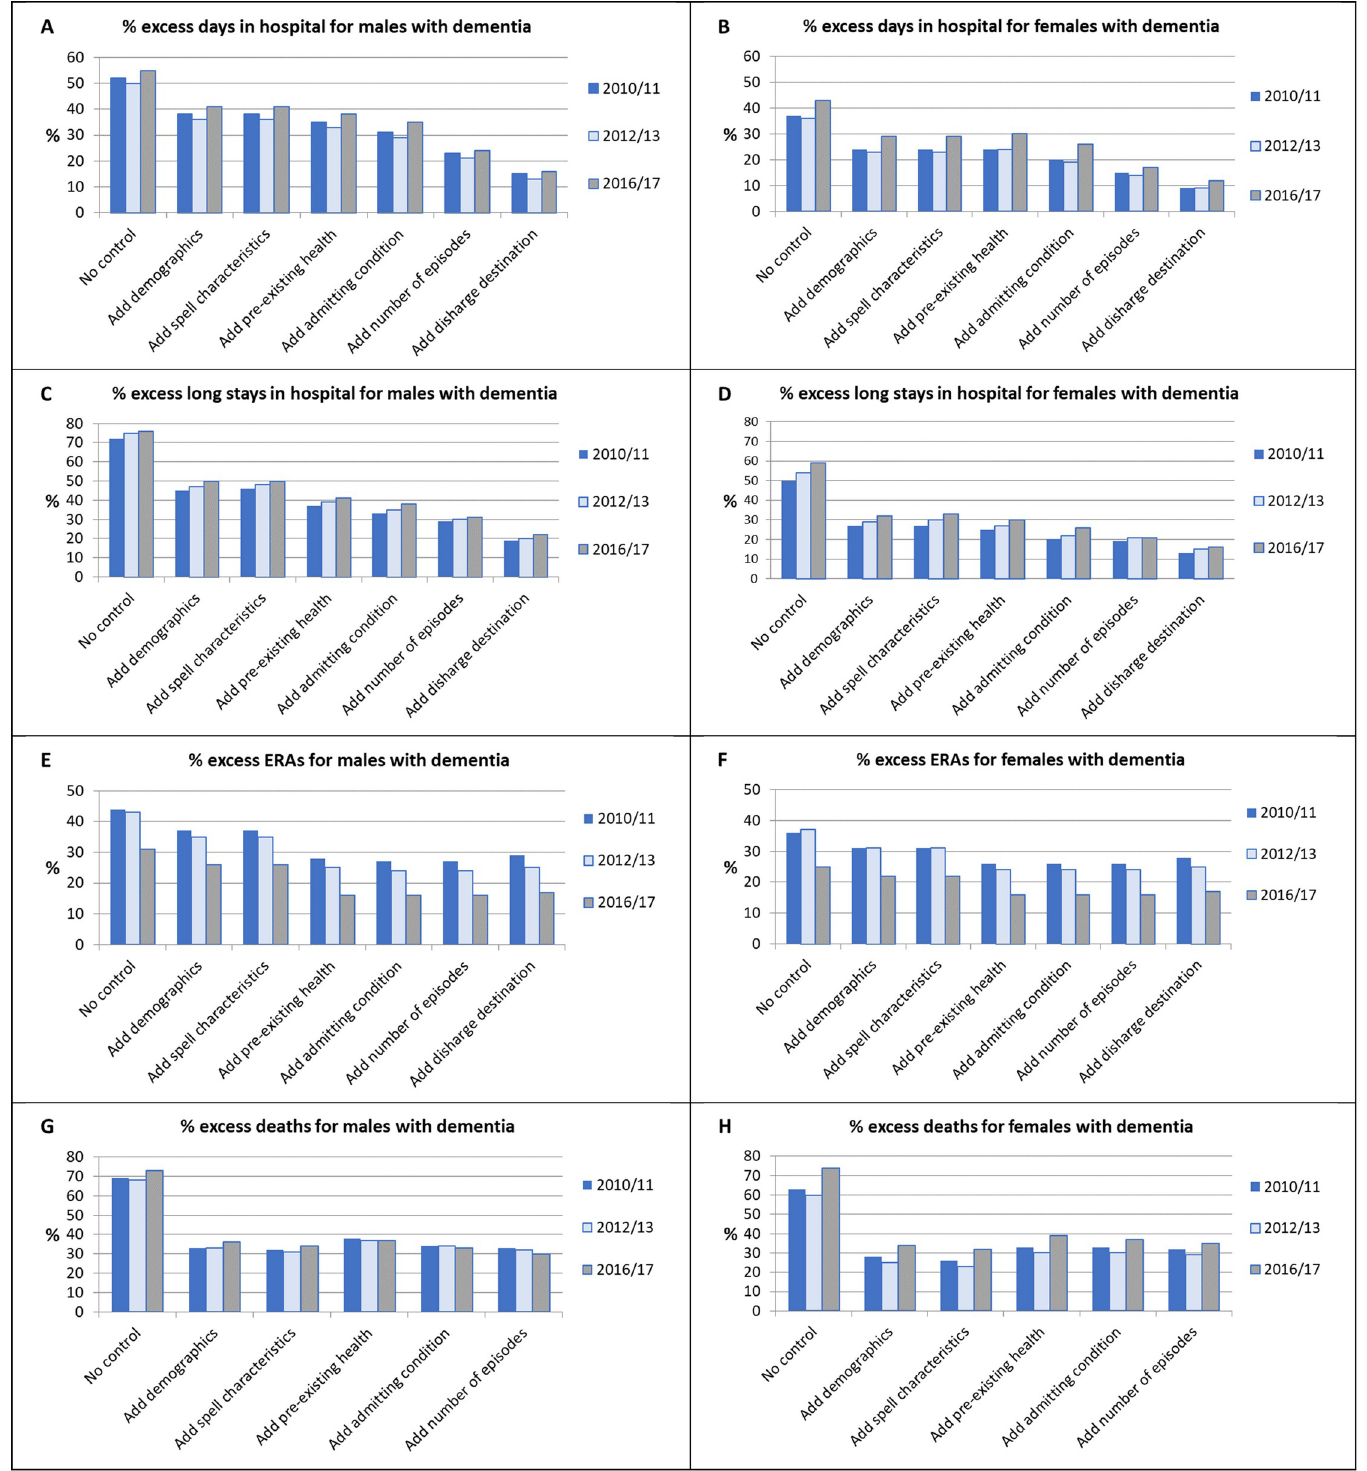
Fig 2. Patient group differences resulting from each step in the hierarchical regression analysis. For death as an outcome, discharge destination was excluded from the models.